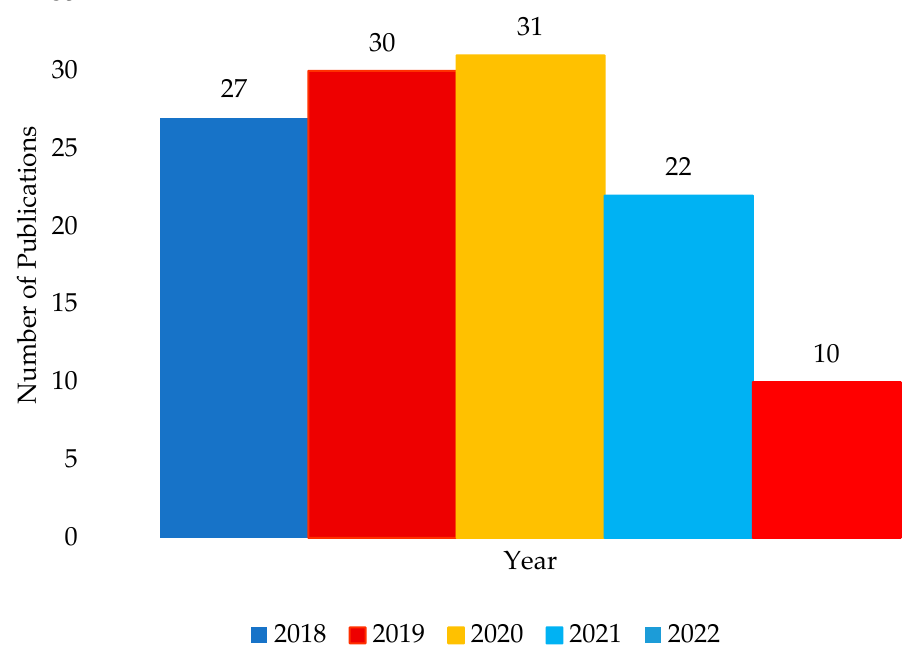
Figure 9. Publications with citations of the terms “FRT”, “LVRT”, and “PMSG” in the titles, keywords, or summaries. Database extracted in August 2022.